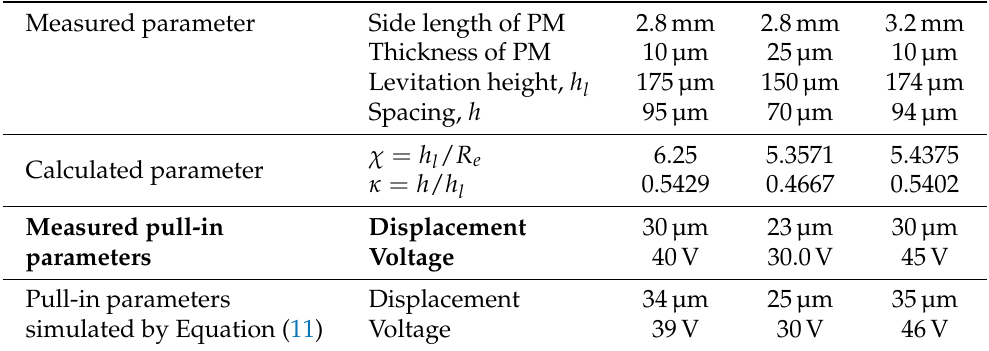
Table 1. Results of measurements and modeling of the static pull-in actuation. Measured